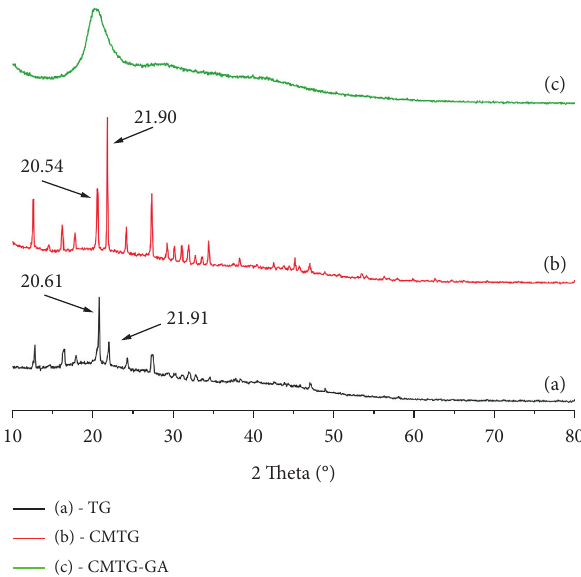
Figure 6: XRD patterns of TG (a), CMTG (b), and CMTG-GA